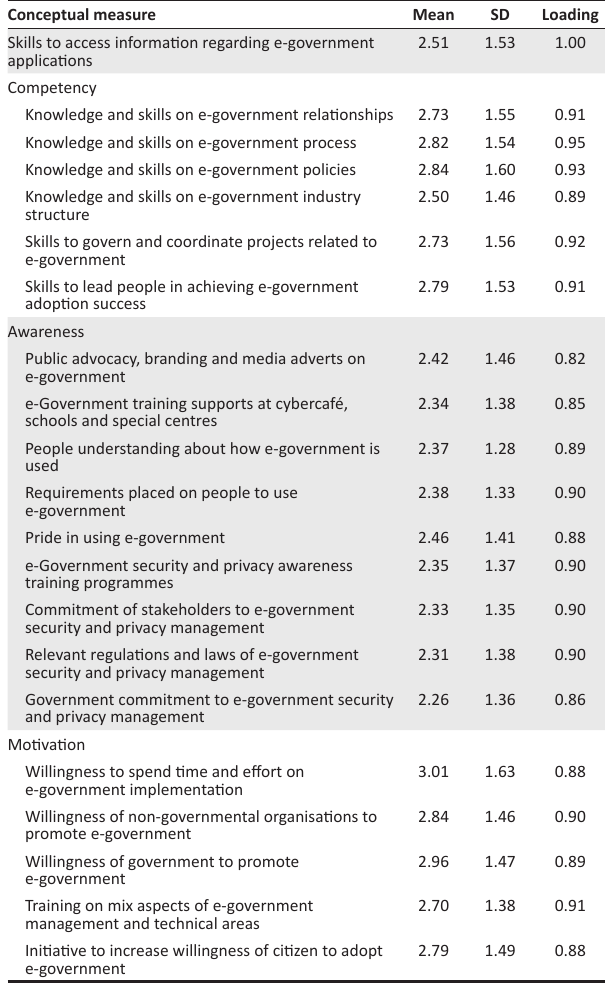
TABLE 3: Confirmatory factor analysis of supporting e-services. TABLE 4: Confirmatory factor analysis of individual citizen